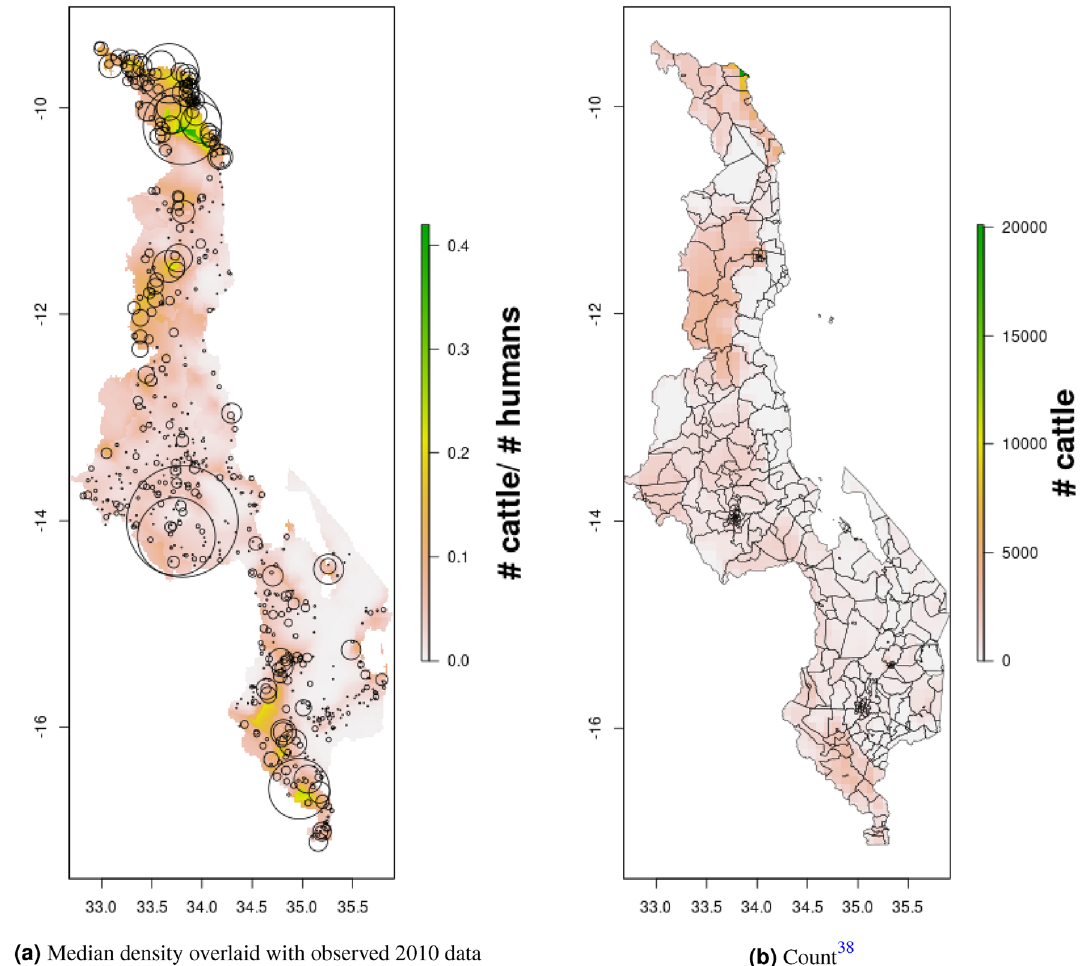
Figure 10. Median cattle density (L) compared with estimated cattle counts produced by GLW-3 (R) for Malawi, both 2010.Observed density data for 2010 are presented on the left, indicated by circle size; this figure does not represent the contribution of data from other years to the model for 2010 via the temporal random effect, nor the contribution from predictors 16